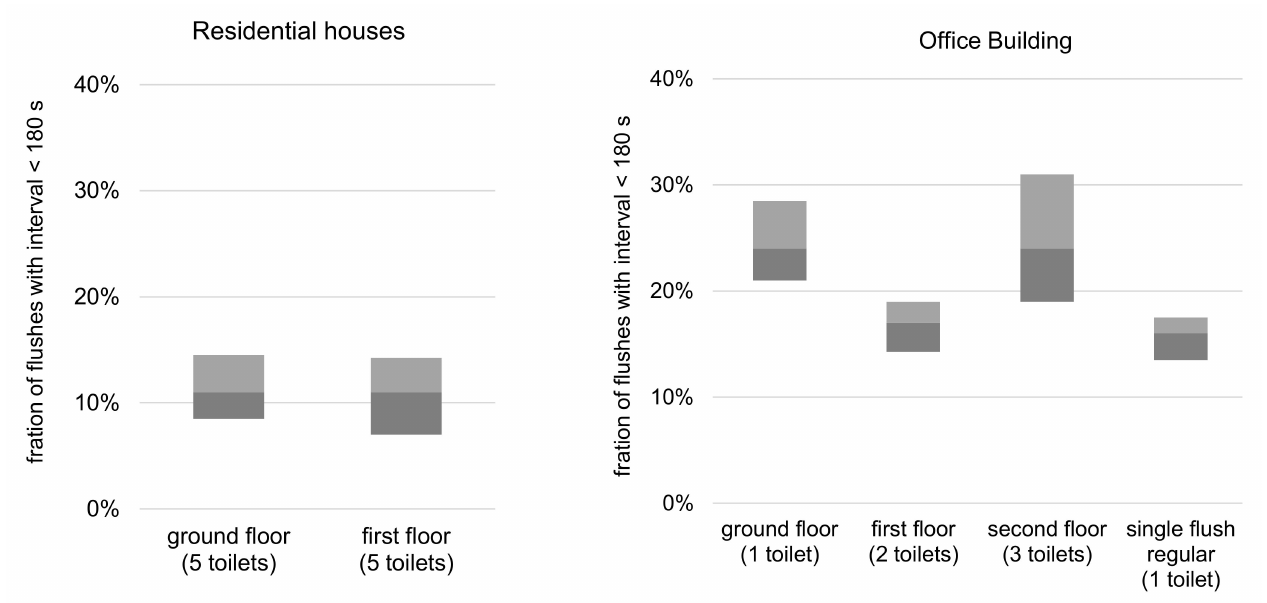
Figure 3. Fraction of flushes occurred upon 180 s to the previous flush at the same toilet identified as putative double flushes of office building including the two toilets with only one flushing button (single flush) and residential houses. The bars show the variation of the monthly average values per toilet, with the intervals between median and first and third